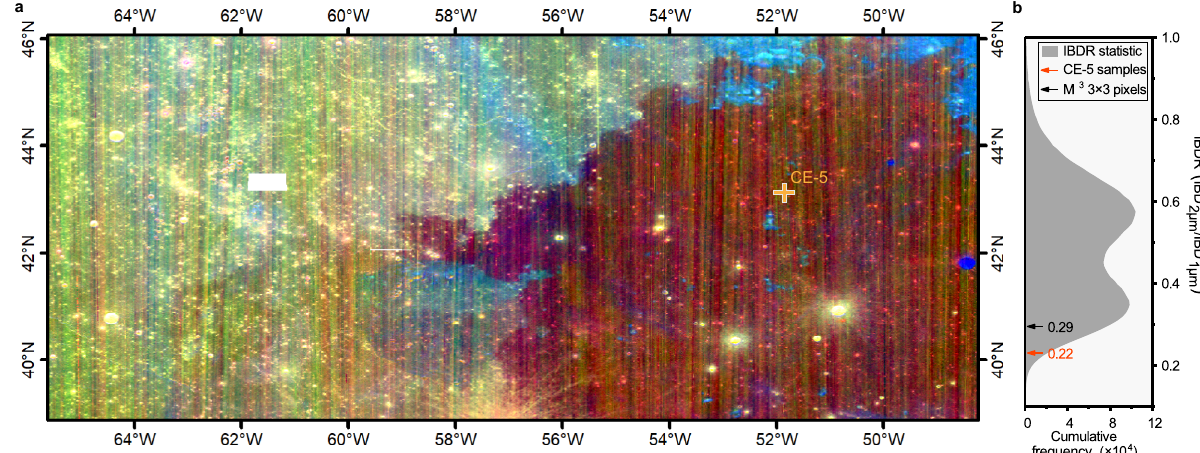
Fig. 1 | Moon Mineralogy Mapper (M 3 ) integrated band depth (IBD) map of the CE-5landing areaand its integratedband depth ratio (IBDR)statistic. a M 3 IBD map of the CE-5 landing area (R: IBD 1 μ m , G: IBD 2 μ m , B: 1500nm re fl ectance). Era- tosthenian (Em) late-stage mare (P58 unit) shows a red hue while Imbrian (Im) old mare to the west of the CE-5landing site shows a green-yellow hue. The solidcross indicates the CE-5 landing site. b The IBDR statistic of P58 unit and adjacent older mare basalts to the west. The IBDR statisticshows a bimodaldistribution. IBDRs of